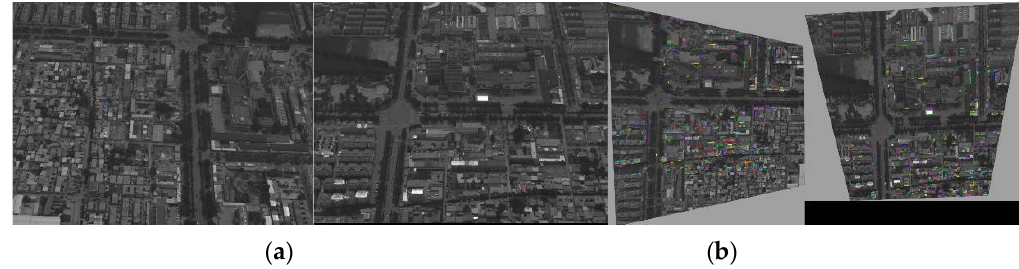
Figure 12. Comparison of the line matching results of the third image pair between original images and rectified images: ( a ) original images, 0/14/0%; ( b ) rectified images, 345/397/86.9%.